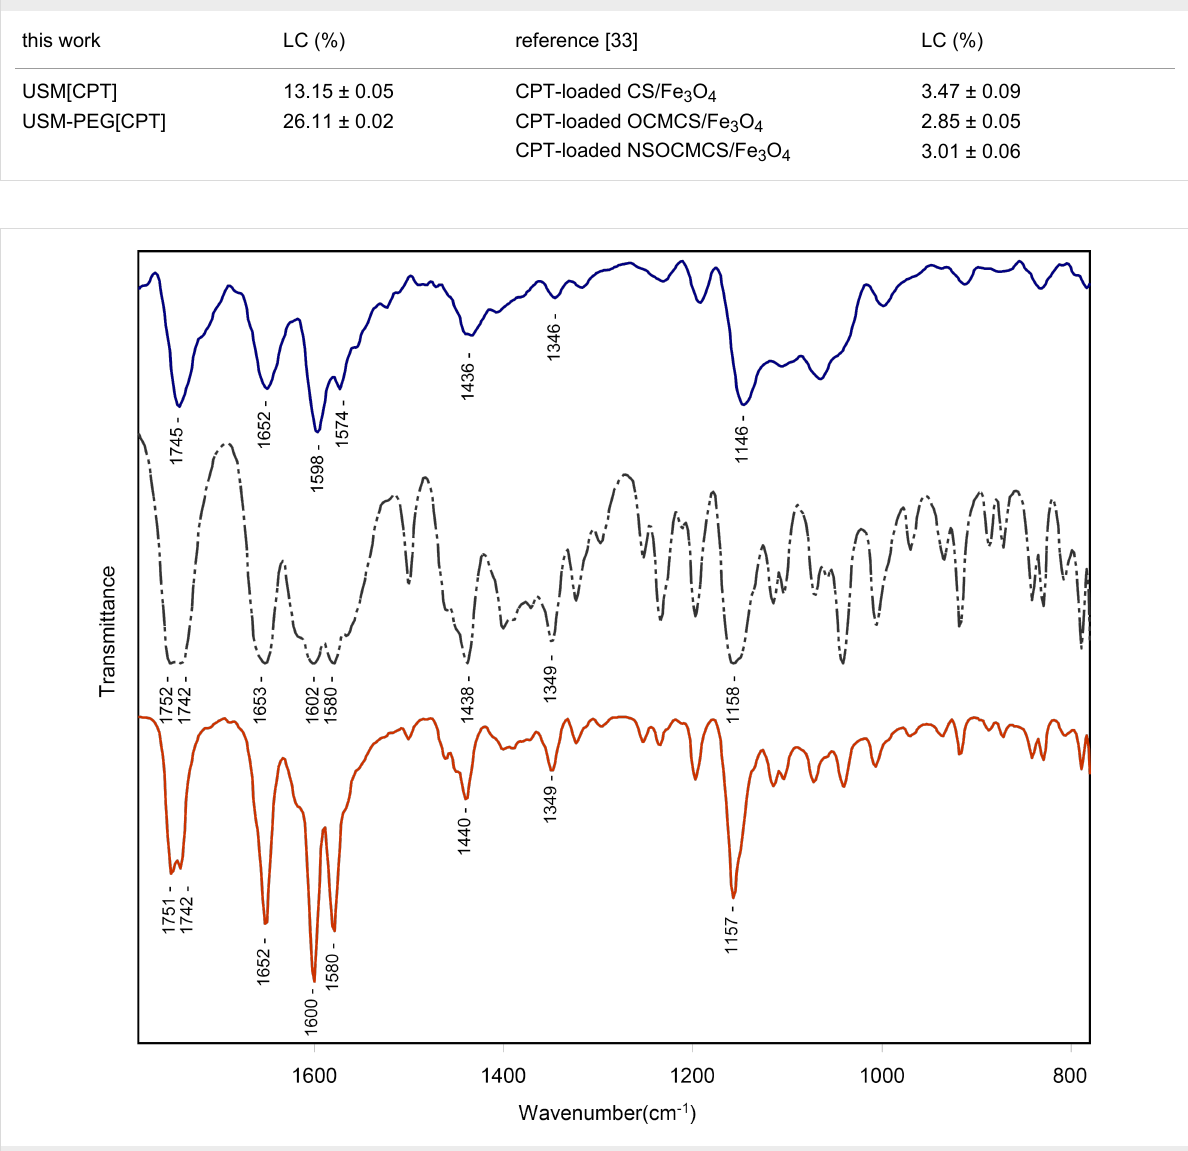
Table 2: Maximum loading capacities of USM[CPT] and USM-PEG[CPT] nanoparticles calculated according to Equation 1 and compared to [33].